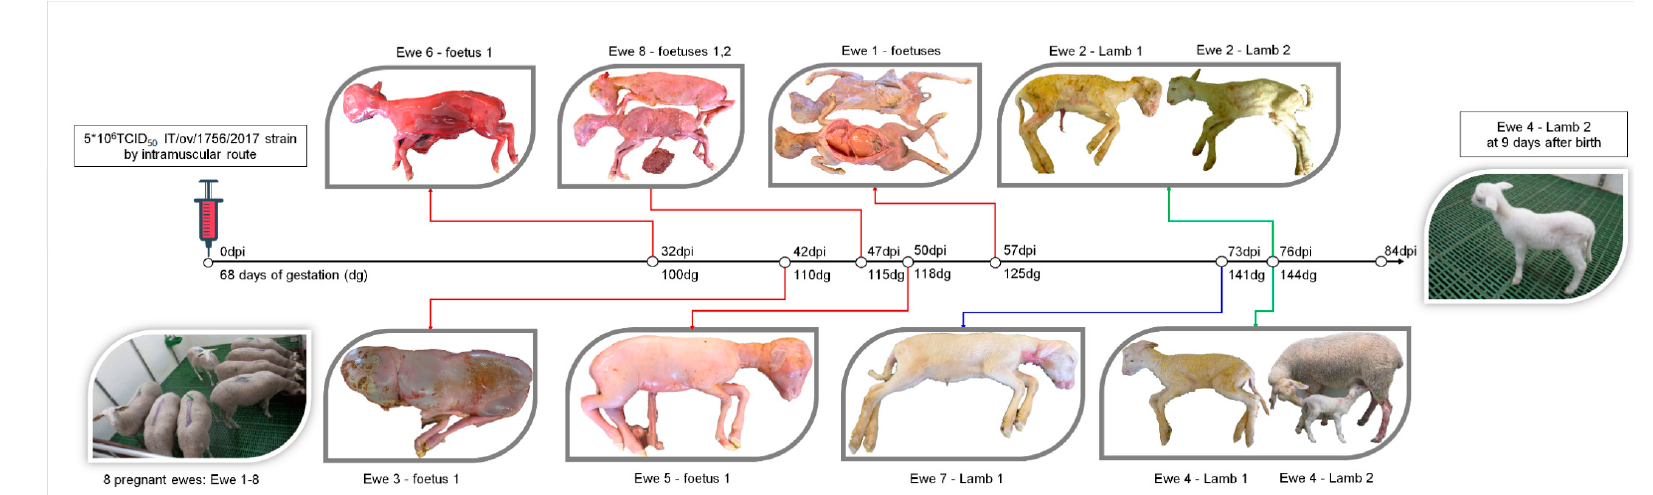
Figure 1. Evolutionary timeline of abortions and stillbirths after Ovine pestivirus (OVPV) infection in pregnant ewes. Pregnant ewes 1 to 8 were infected with OVPV at 68 days of gestation. The ewes were monitored clinically on a daily basis during the 84 days of the study. The abortions (red line), premature stillbirth (blue line), and non-premature stillbirth (green line) of ewes are shown. Lambs that reached term and were born alive are also shown.